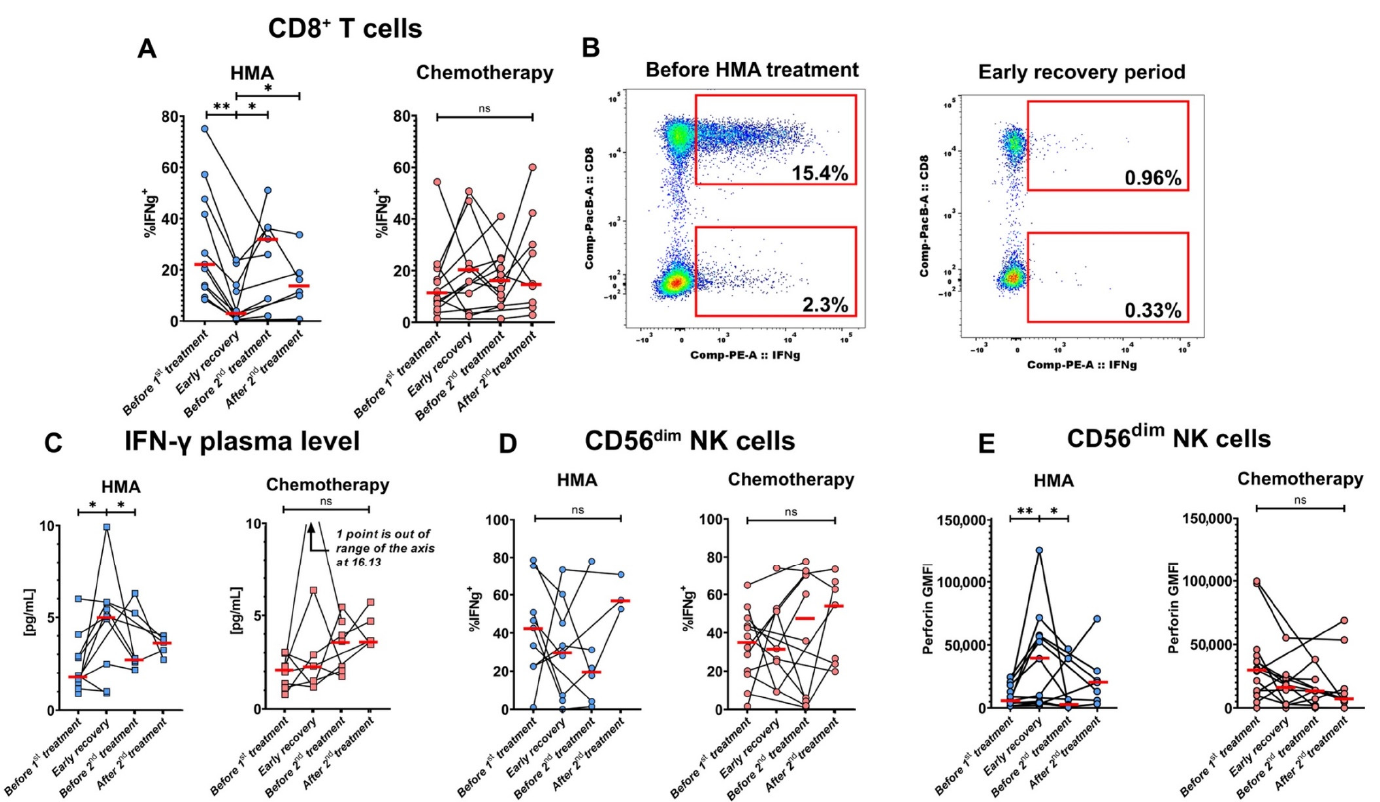
Figure 4. HMA/venetoclax treatment inhibits IFN- γ production by T cells and enhances perforin accumulation in cytotoxic lymphocytes. AML patients were divided into treatment groups: (1) HMA/venetoclax (“HMA”, blue circles, n = 12 for T cell assay, n = 10 for NK cell assay) and (2) IC (“Chemotherapy”, pink circles, n = 14 for T cell assay, n = 13 for NK cell assay). All patients with >1 sample collected were included in the plots. ( A ) Dynamics of % IFN- γ -secreting CD8 + T cells during HMA/venetoclax (left) and IC (right) treatments. ( B ) Representative flow cytometry dot plots of changes in frequencies of IFN- γ -secreting CD8 + T cells before treatment (left) and after the induction of HMA/venetoclax therapy (right) from patient #28 (see Supplementary Table S1). The clusters of cells displayed at the bottom of each panel are CD4 + , and top clusters are CD8 + . Numbers are percentages of total CD4 + and CD8 + T cells. ( C ) Dynamics of IFN- γ level in plasma from AML patients treated with HMA/venetoclax (left) and IC (right). ( D ) % IFN- γ -secreting CD56 dim NK cells during the courses of HMA/venetoclax (left) and IC (right). ( E ) Change in CD56 dim NK cell perforin GMFI under HMA/venetoclax treatment (left) and IC (right). Red bars represent medians. Wilcoxon signed-rank test was used for statistical analysis. ns— p > 0.05; *— p < 0.05; **— p <